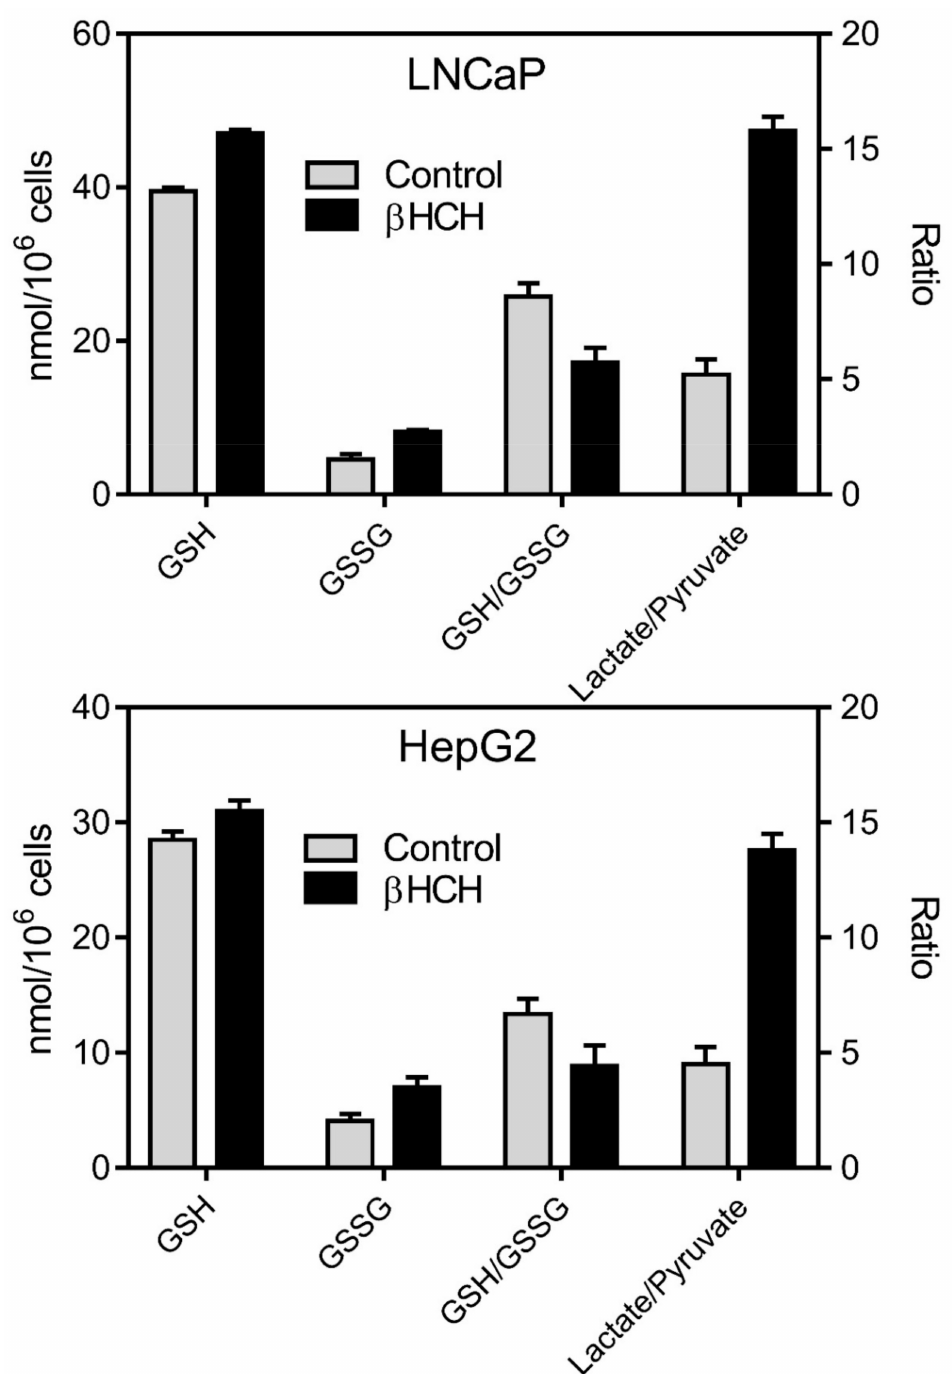
Figure 9. Impact of β -HCH on glutathione redox state and cell metabolism. The increase in glutathione oxidized form (GSSG), with a consequent decrease in GSH (reduced glutathione) / GSSG ratio, proves that 10 µ M β -HCH can induce oxidative stress after 6 h treatment in both LNCaP and HepG2 cells. Analysis were carried out on 10 6 cells. In addition, a sharp increase in Lactate / Pyruvate ratio is detectable in the culture media of both LNCaP and HepG2 cells stimulated with 10 µ M β -HCH for 6 h, demonstrating an enhancement in lactate production induced by β -HCH. All the di ff erences between control and β -HCH treated samples are statistically